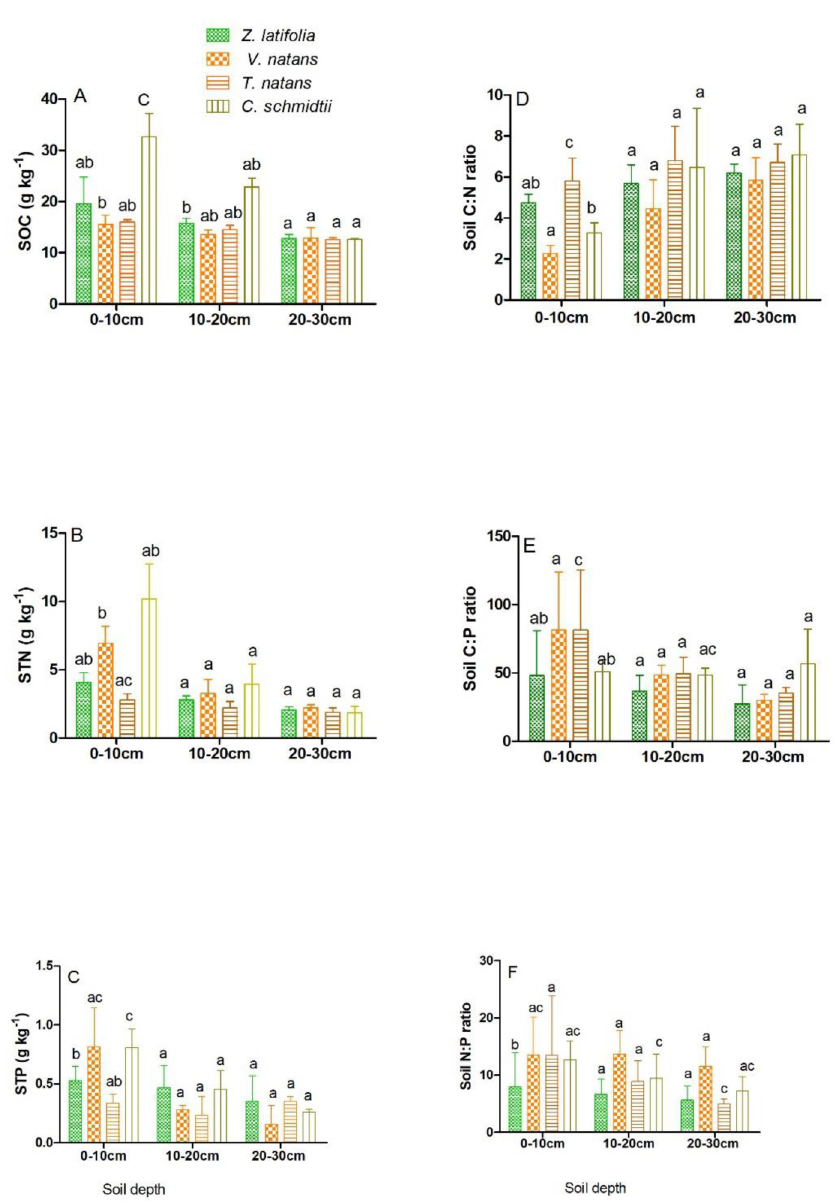
Fig 2. The vertical distribution of soil organic carbon- SOC -(2A), soil total nitrogen STN- (2B), soil total phosphorus STP- (2C), C:N-(D), C:P-(2E), N: P-(2F). Figures represent Mean ± SD, different letters show significant difference at p <